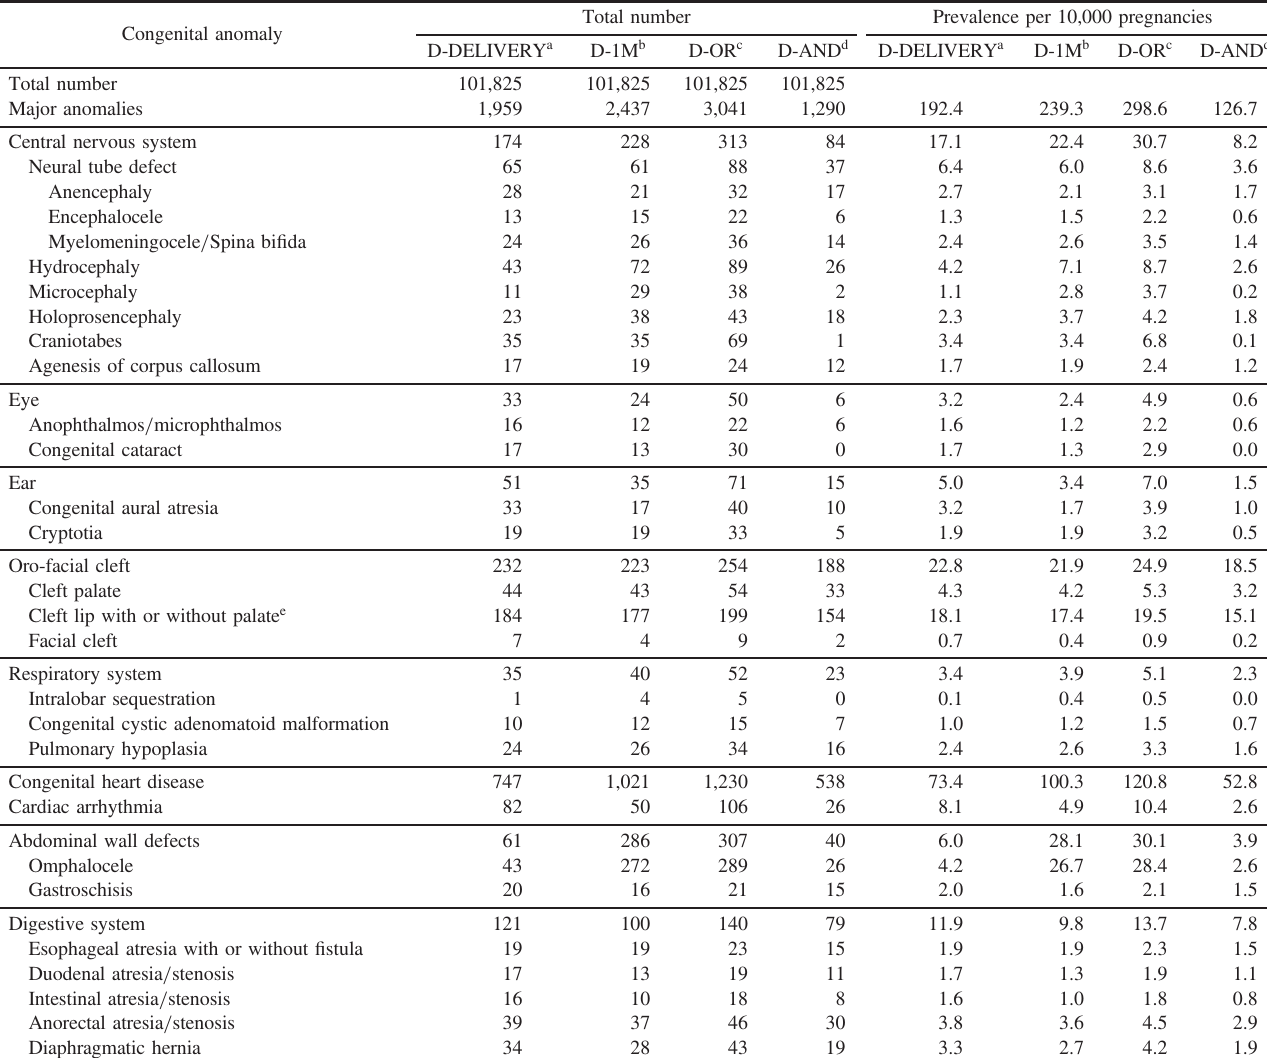
Table 2. Number and prevalence per 10,000 pregnancies of the 61 congenital anomalies of interest according to reporting pattern Congenital